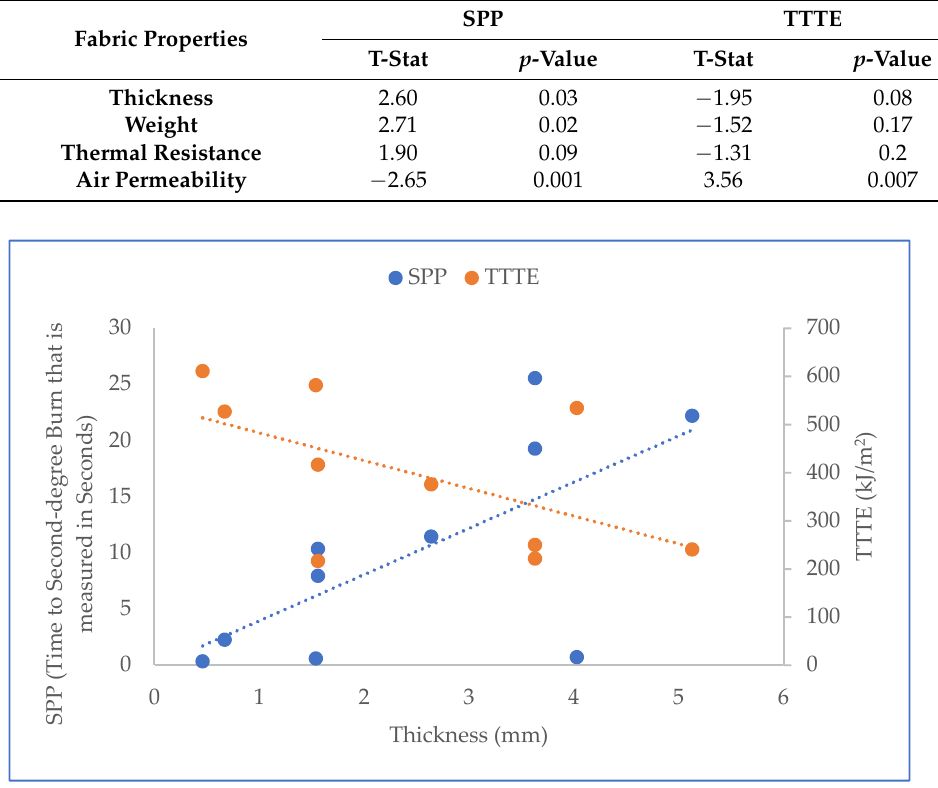
Figure 5. Relationship plot of weight with SPP and TTTE.